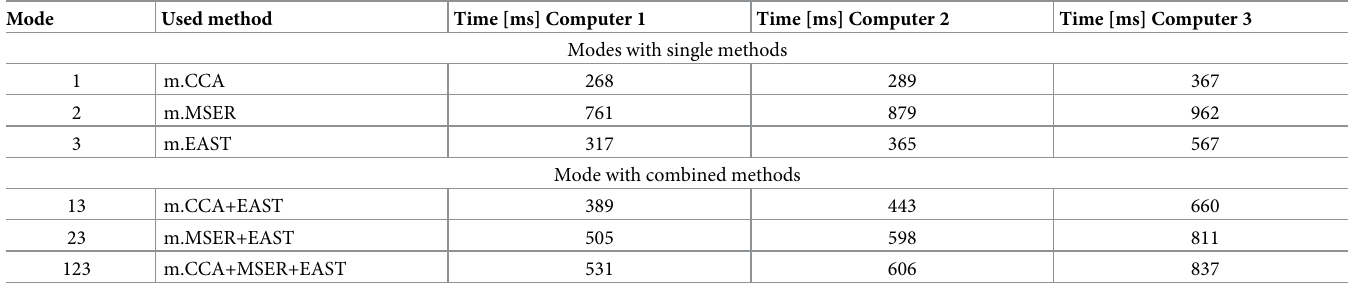
Table 1. Average vessel identification speed for dataset A.